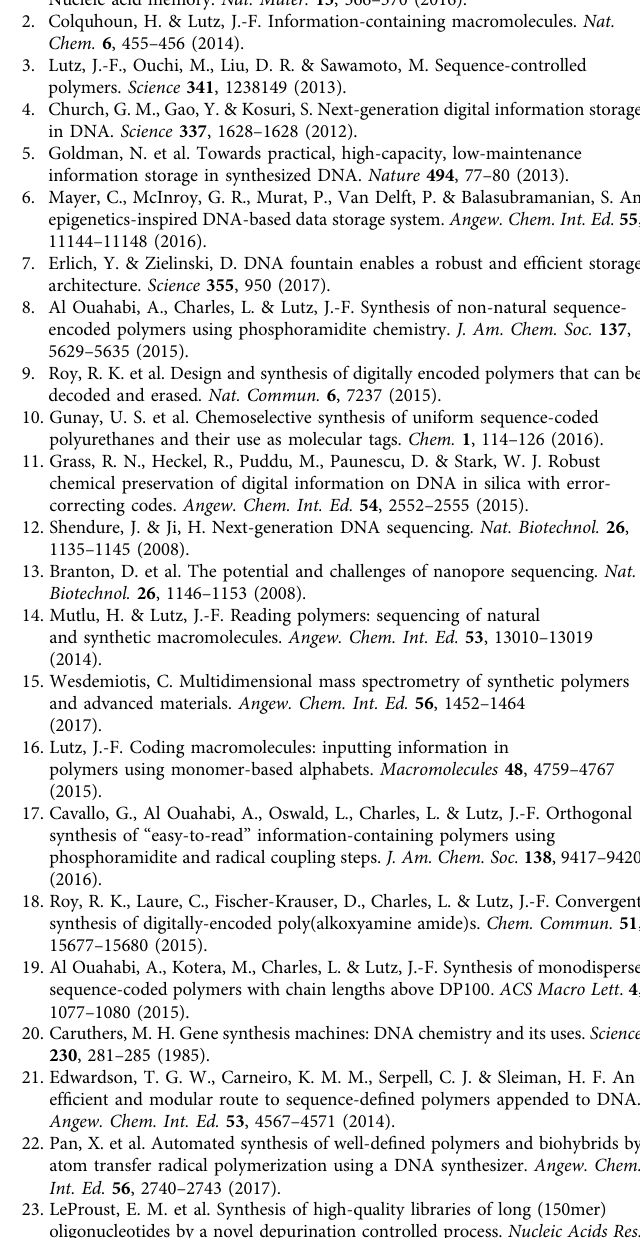
protocol 19 . After removal of the capped failure sequences, the terminal DMT group of the targeted sequence-coded polymers were cleaved on the column and washed out by solvent elution 19 . The isolated polymers solutions were lyophilized, then weighed and the recovery yields are summarized in Supplementary Table 1. A typical 1 H NMR spectrum of a puri fi ed polymer is shown in Supplementary Fig.